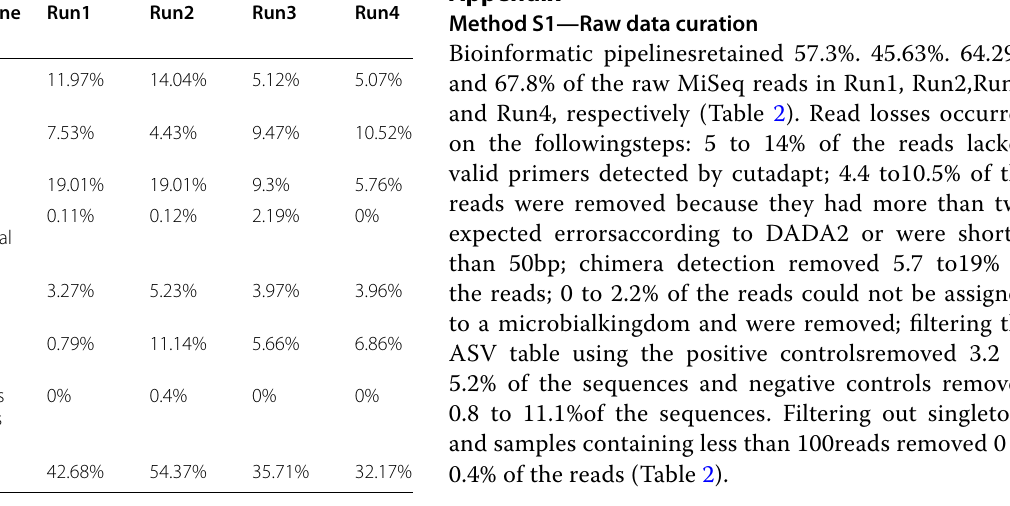
Table 2 Percentage of reads lost at each stage of the bioinformatic pipeline and over the entire bioinformatic process, for each Illumina MiSeq run Bacteria Fungi